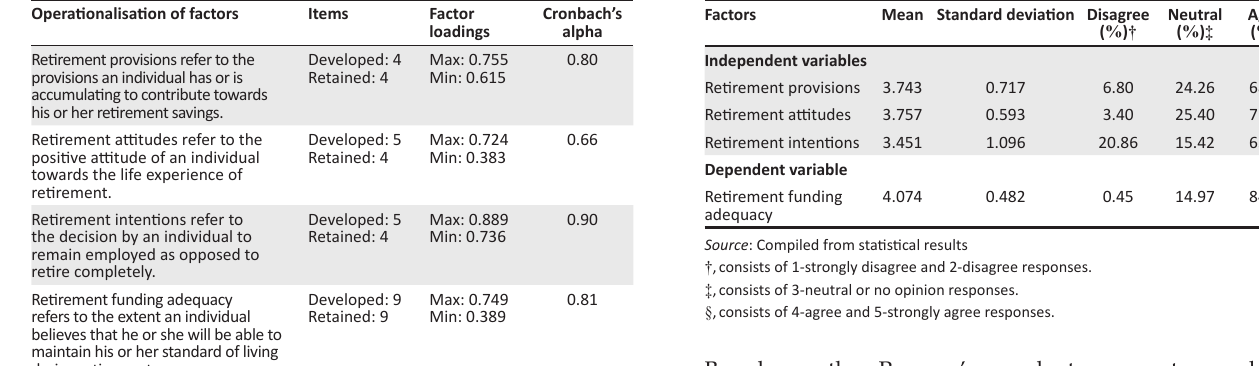
Operationalisation of